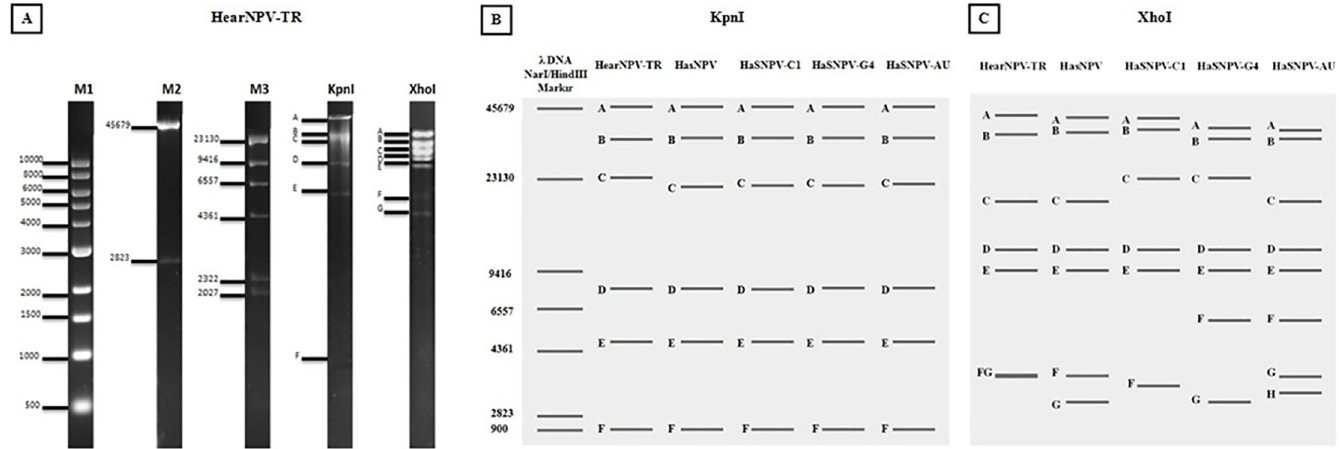
Fig 4. Restriction endonuclease (KpnI and XhoI) profiles. A: Restriction analysis by electrophoresis of HearNPV-TR, B-C: Restriction endonuclease profiles (KpnI and XhoI) of HearNPV-TR, HasNPV, HaSNPV-C1, -G4, -AU based on the full genome sequence using Benchling online tool.